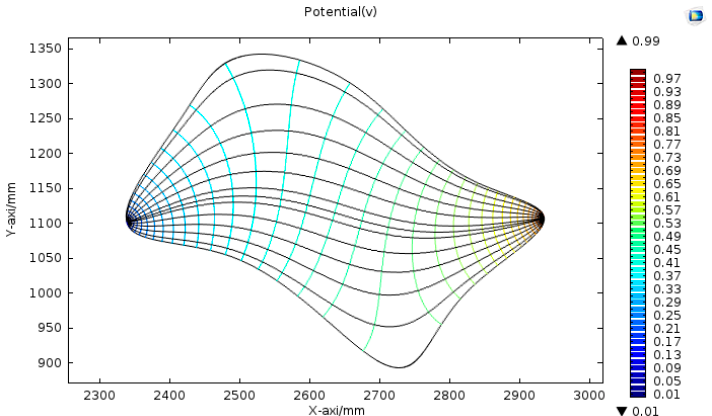
Figure 3. Electric field distribution and potential distribution in the conductive plane.